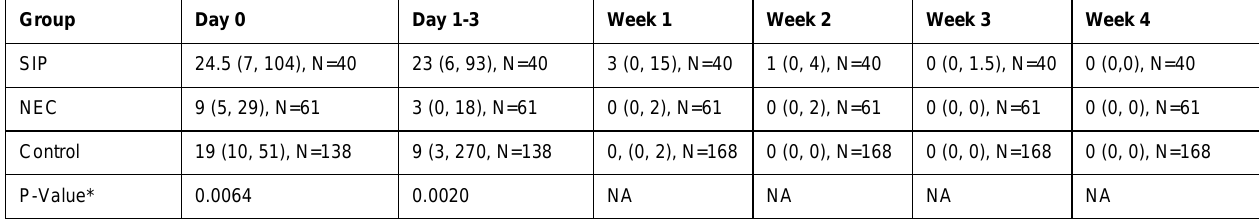
Table 4. Median (Q1, Q3) of NRBC by DOL